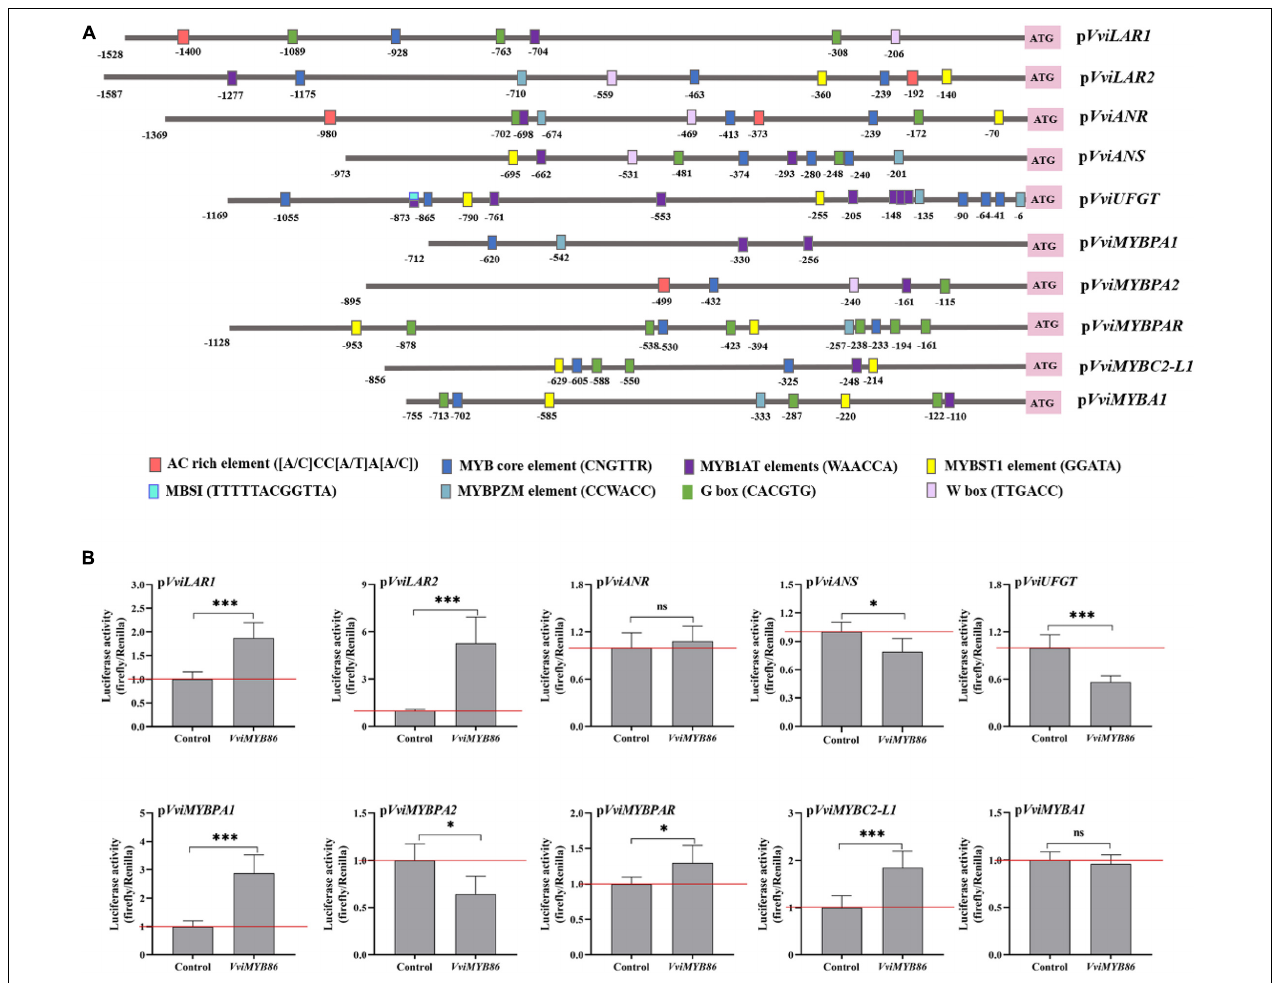
FIGURE 4 | The influence of VviMYB86 on the promoters of structural and regulatory genes in PA and anthocyanin synthesis. (A) The characteristics of cis -elements for binding of MYB, MYC and other proteins in structural and regulatory gene promoters of PA and anthocyanin synthesis. (B) Effects of VviMYB86 on the activities of gene promoters of PA and anthocyanin synthesis as determined by dual luciferase assay. Control indicated the activity of the promoter transfected with the empty vector (pCAMBIA 1301). Normalized luciferase activity was calculated as the ratio between firefly and Renilla reniformis luciferase activities. Each column represents means ± SD from four biological